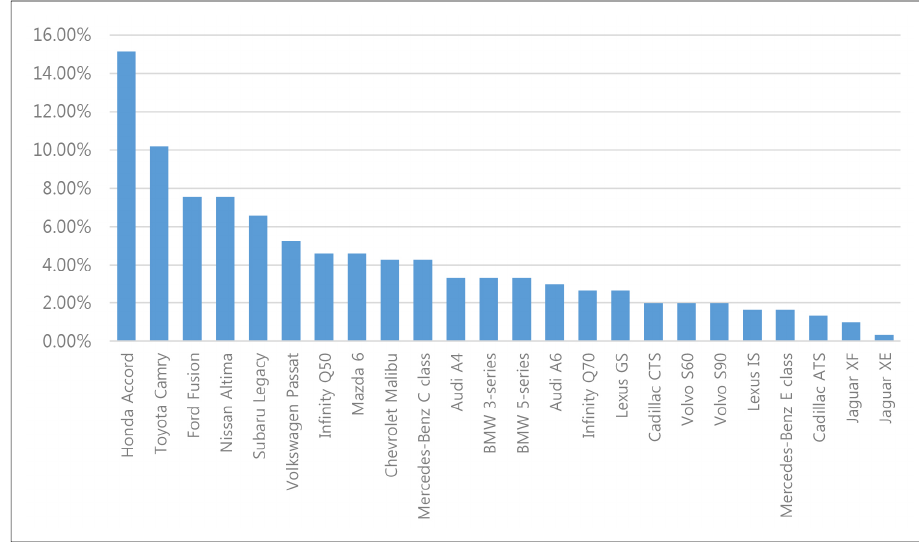
Data created by authors through a despite its value as a vehicle.